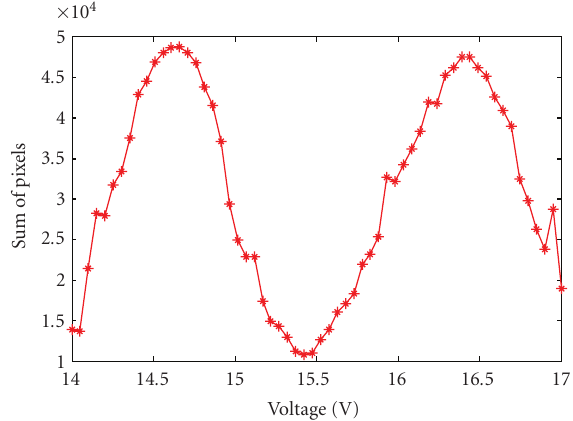
Figure 6: Calibration curve for PiezoJena actuator (Piezosystem Jena, PZ38CAP) driven using controller: NV401CLE. The intensity varies from a maximum at ∼ 14.6 V, to a minimum at ∼ 15.5 V, corresponding to a π/ 2 phase shift.